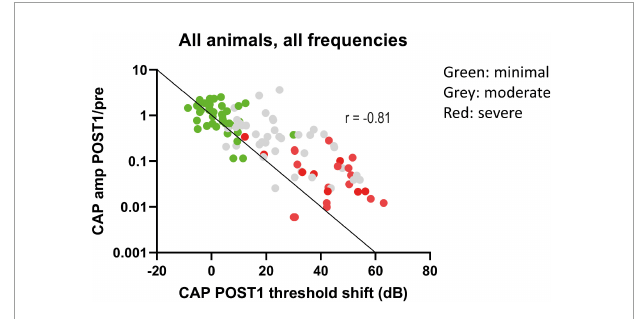
FIGURE9 The CAP amplitude ratios (POST1/PRE) at ∼ 90 dB SPL were plotted against CAP threshold shifts at POST1. Data points represent all individual responses of all animals to the tested frequencies (0.25–16 kHz, octave steps). The data points are dispersed according to trauma group, with minimal trauma animals having less decline of amplitude and threshold shift increase. The line represents the 1 dB amplitude decrease with 1 dB threshold shift. A decrease of these amplitudes at 90 dB SPL was strongly correlated with threshold shifts (Spearman’s r = –0.81, p <